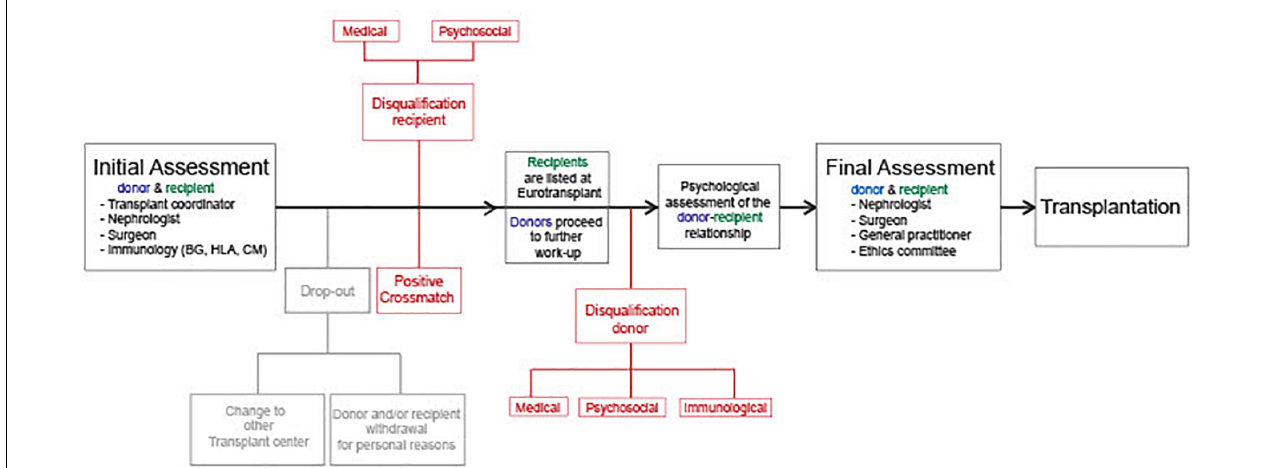
FIGURE 1 | Flow chart of the LKD program: Flow chart depicting the assessment of potential living kidney donors and recipients at the LMU University Hospital Munich. The black arrow represents a timeline with the stages of the living kidney donor (LKD) program leading to successful transplantation. Donors and/or recipients withdrawing the LKD program due to relocation to another transplant center or undetermined personal reasons are highlighted in gray. Recipients and/or potential donors disqualified from the LKD program are represented in red. BG, blood group; HLA, human leucocyte antigen; CM,